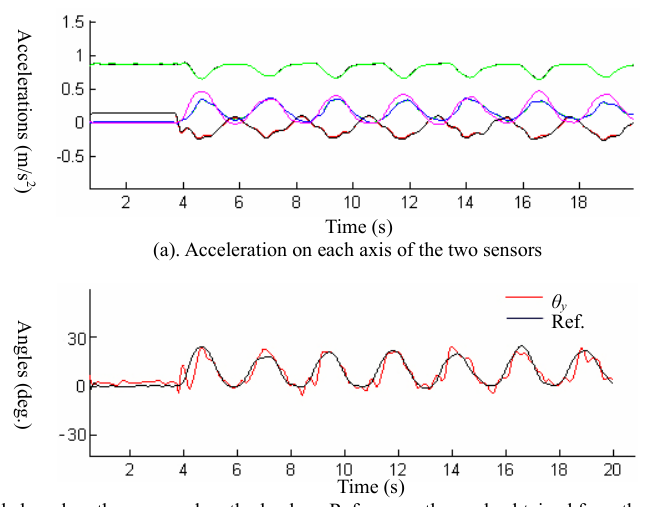
Fig.10 Experiment data from the simple